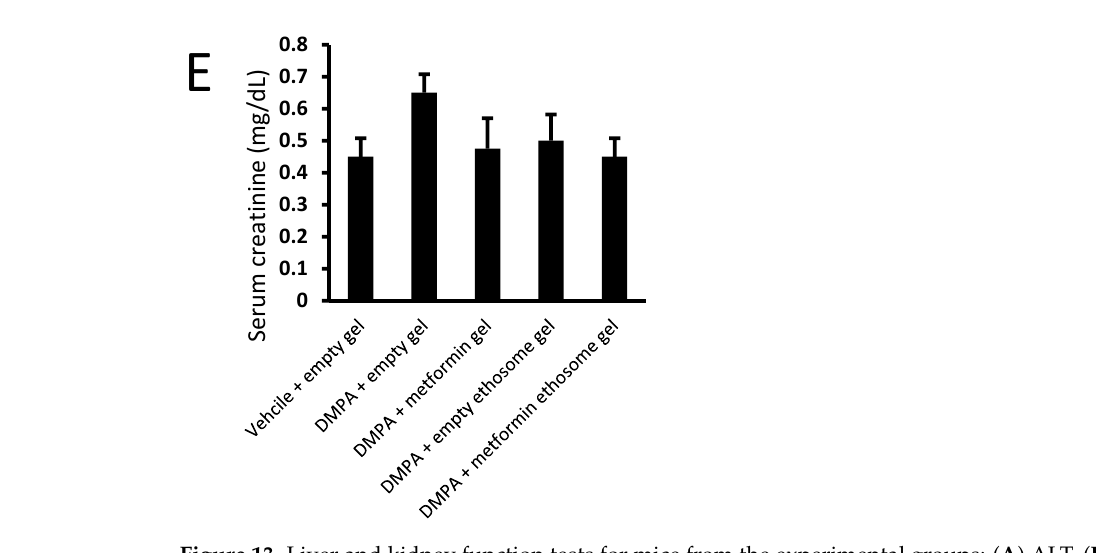
Figure 13. Liver and kidney function tests for mice from the experimental groups: ( A ) ALT, ( B ) AST, ( C ) albumin, ( D ) urea and ( E ) creatinine. Data were the mean ± SD, and the analysis was done by one-way ANOVA at p < 0.05.